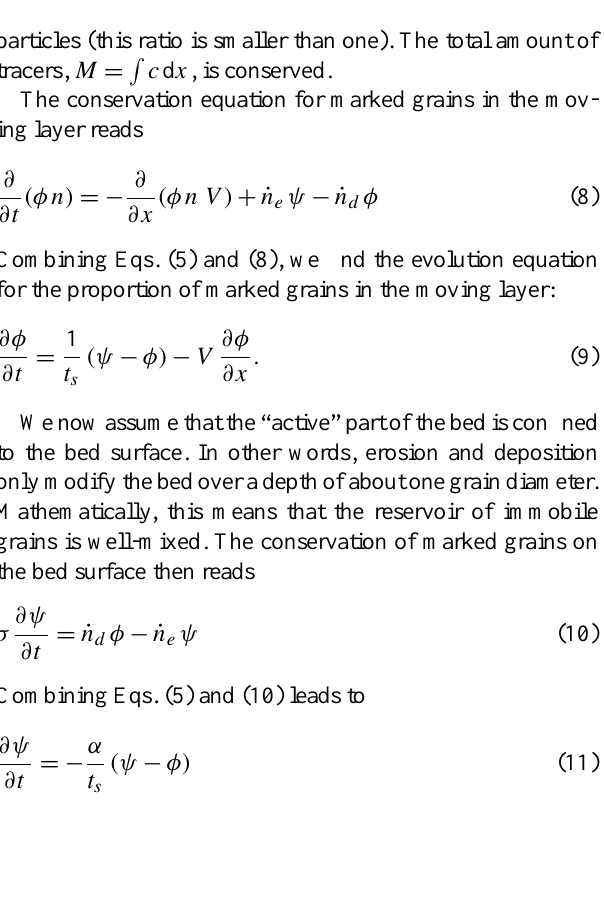
Complemented with initial and boundary conditions, Eqs. ( 9) and (11) represent the evolution of the proportion of marked